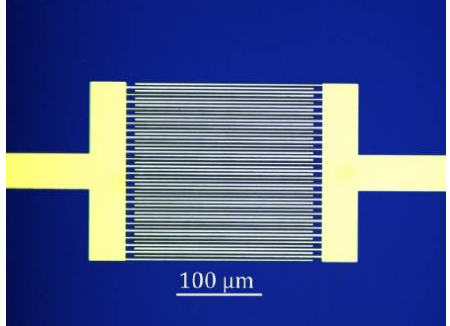
Figure 6. Optical image of Au interdigitated electrode (IDEs) on SiO 2 /Si substrate for a graphene chemiresistor sensor. The sensing area is of 200 × 200 µm 2 . The finger width and finger space are consistent (2 µm).